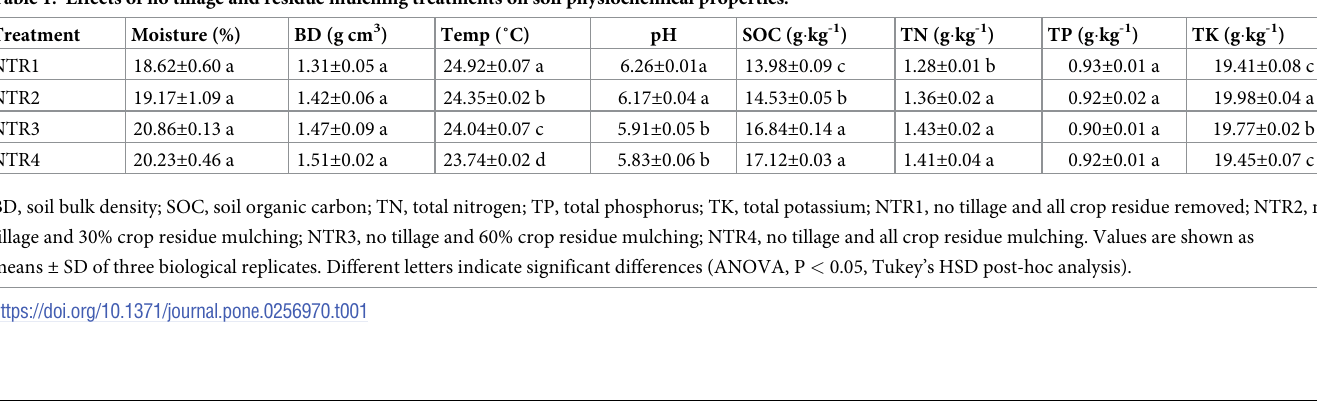
Table 1. Effects of no tillage and residue mulching treatments on soil physiochemical properties. Treatment Moisture (%)